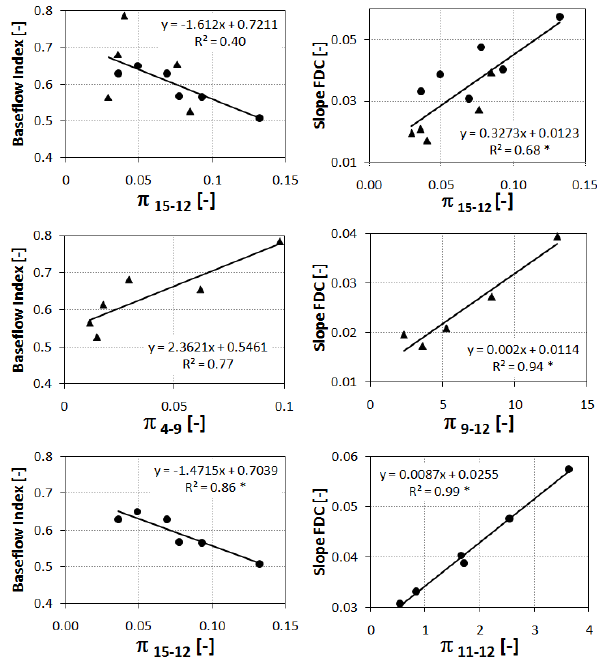
Figure 11 : Significant linear relationships between baseflow index and slope of the FDC and different dimensionless numbers related to model time scales (4: root zone filling by rain; 9: transmission zone emptying; 11: Boussinesq aquifer diffusion; 12: deep aquifer; 15: mean inter-storm duration). Triangles indicate no snow catchments and dots represent snow catchments.